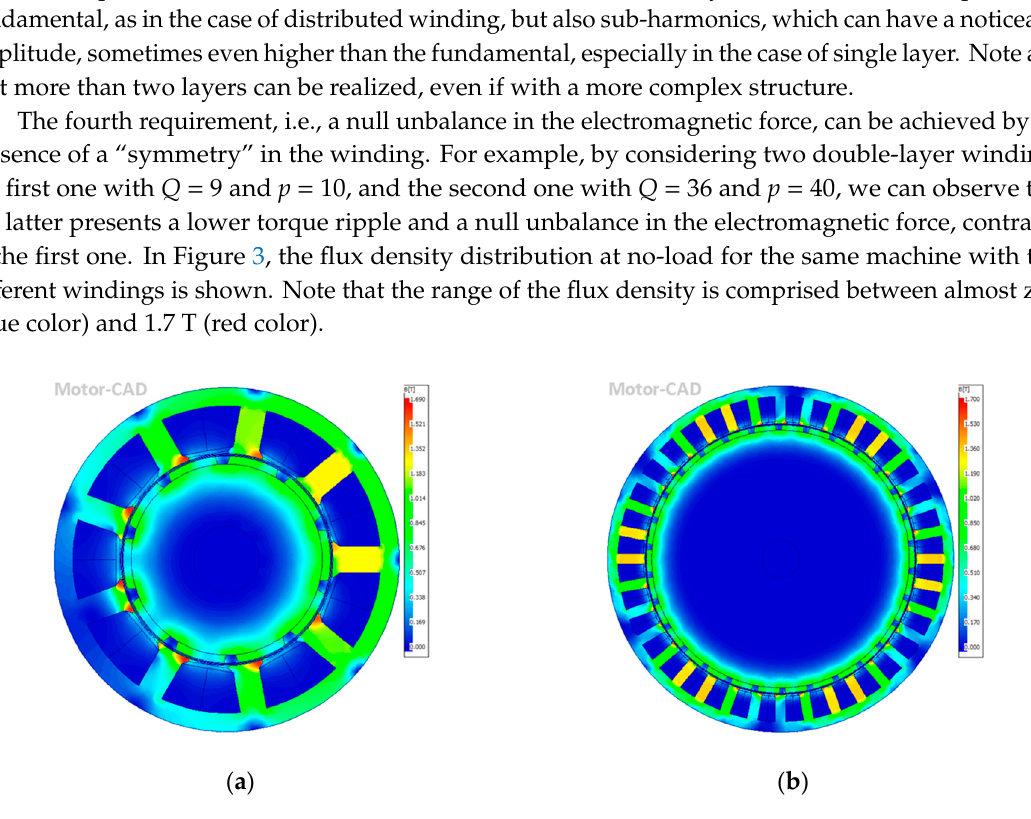
Table 1. Comparison between the single and double layer for a 1.4 kW machine with Q = 12, p = 10. THD BEMF [%] T ripple [%] k w1